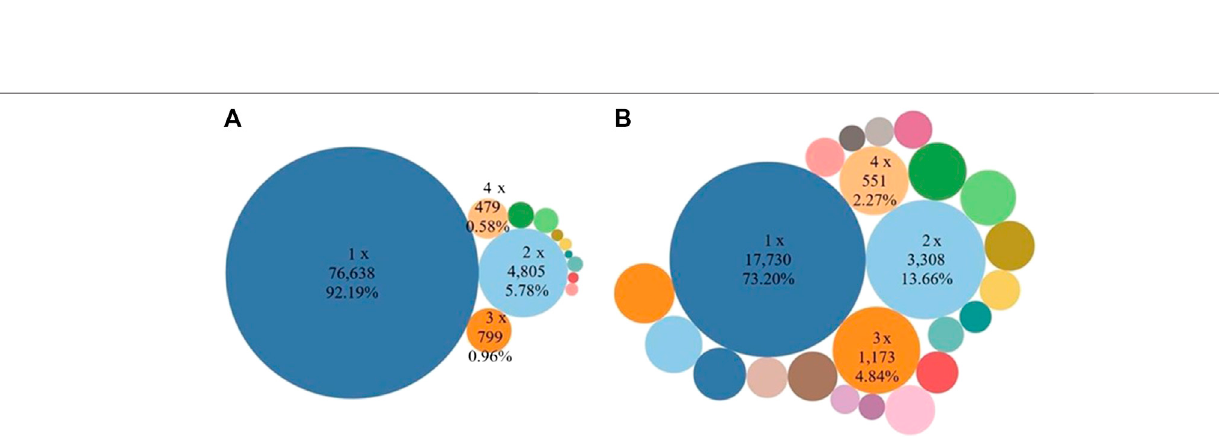
FIGURE 3 | Growth in the rate of research output investigating SDGs over time (1999-2018) analyzed at the author and institutional levels.